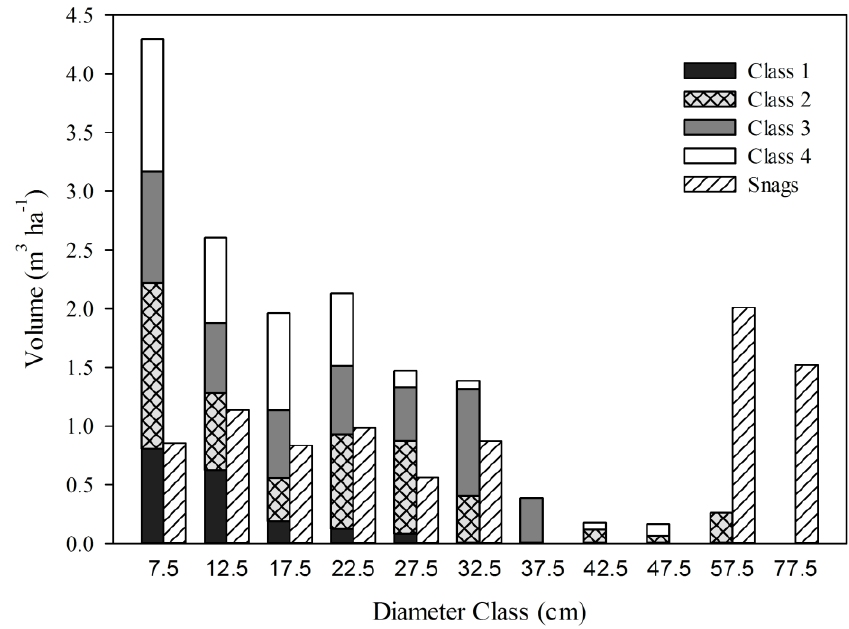
Figure 2. Coarse Woody Debris (CWD) and Snags volume, in m 3 ha −1 , by diameter class and decomposition classes. Decomposition classes: (1) newly fallen to the soil with leaves and tree bark intact; (2) residues similar to those in class 1 but with tree bark showing rot or scaling; (3) residue at an advanced stage of decomposition with some resistance to being broken; (4) rotten and friable residues with no resistance when broken.